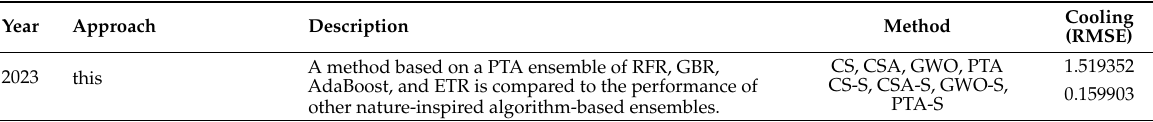
Table 12. Comparison to the Literature